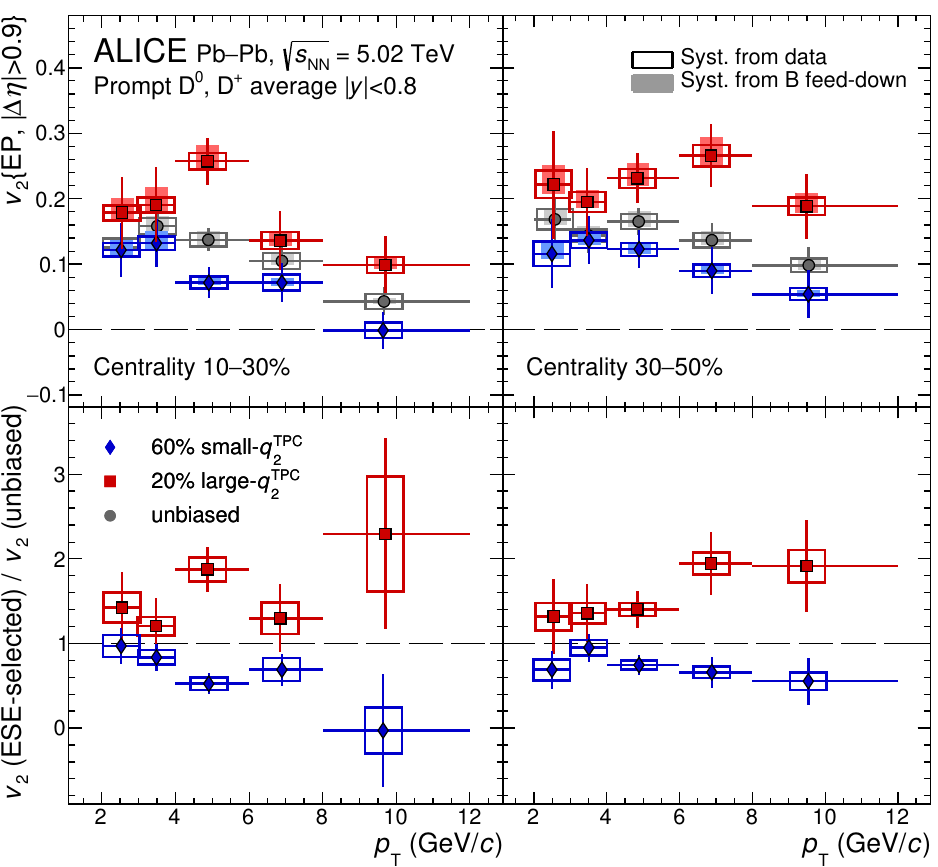
Figure 8 . Top panels: average of D 0 and D + v 2 as a function of p T for Pb-Pb collisions at p s = 5 : 02 TeV in the small- q TPC , large- q TPC (see text for details) and unbiased samples, in the 2 2 NN 10{30% (left) and 30{50% (right) centrality classes. Bottom panels: ratios of the measured v 2 in the ESE-selected classes to the one obtained from the unbiased